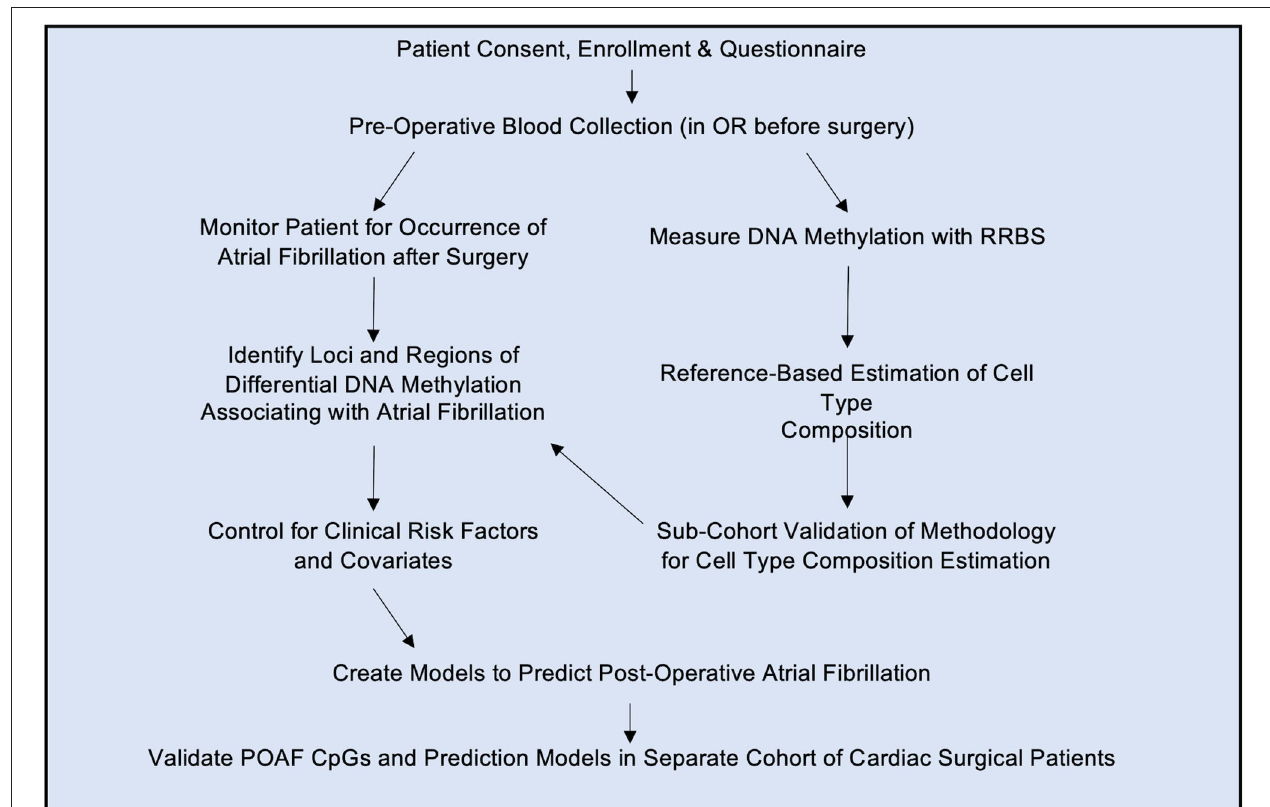
FIGURE 1 | Study Design. Patients giving informed consent were enrolled in the study and a blood sample was drawn in the operating room (OR) prior to surgery. Genomic DNA was isolated from blood and subjected to reduced representation bisulfite sequencing (RRBS). The resulting methylation status was determined as described in the text. Patients were monitored for post-operative atrial fibrillation and differential DNA methylation loci were used to build a model to predict post-operative atrial fibrillation based on pre-operative blood samples. The statistically significant CpGs and predictive model were then analyzed in a separate validation cohort of cardiac surgical